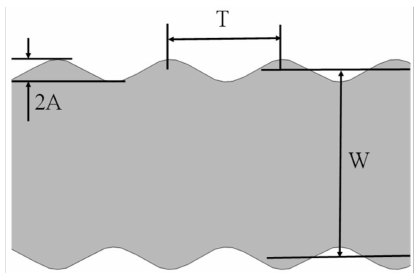
Figure 2. The geometry model for a segment of a sensitive grid in a strain gauge. The parameters of amplitude (A) and period (T) describe the cosine-curve profile. The width (W) of the sensitive grid is located between two dashed lines estimated by the least square methods.